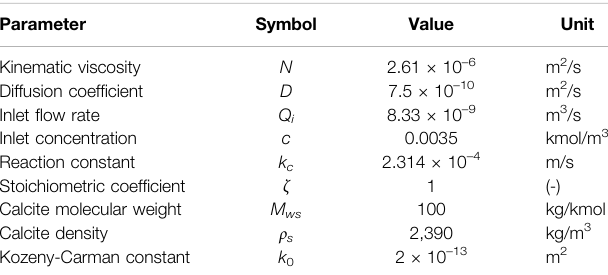
TABLE 5 | Simulation parameters for Benchmark